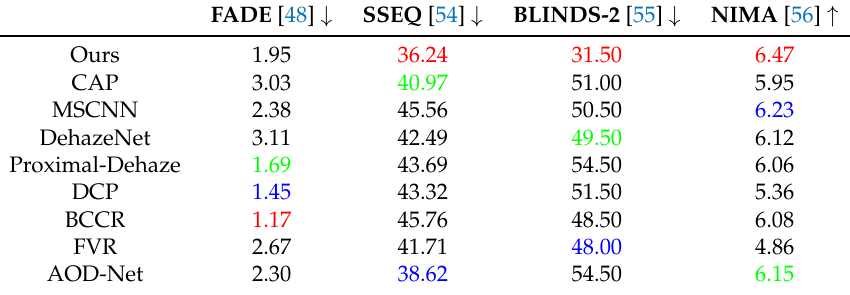
Table 4. Comparison of dehazed image quality using four image quality assessment methods. The top three results are in red, blue, and green font,